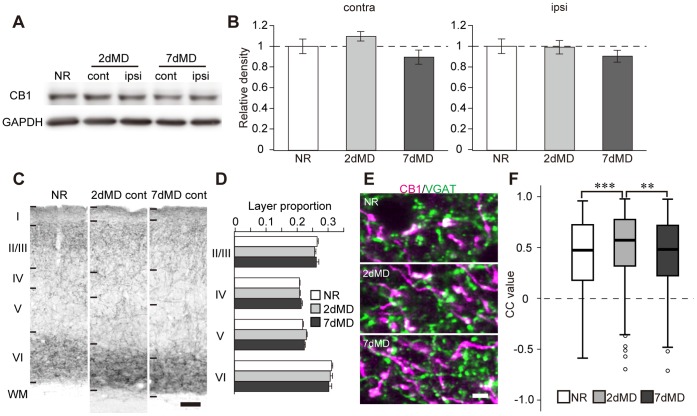
Effects of monocular deprivation on CB1 expression.(A) Representative western blots of CB1 and GAPDH in V1∶2 dMD and 7 dMD indicate monocular deprivation for two days and seven days, respectively. The blots of V1, which is contralateral (cont) or ipsilateral (ipsi) to the deprived eye, are represented with that of the normal animal (NR). (B) Mean and SEM of the blot density of CB1 in MD animals normalized to the mean of normal animals (n = 10 animals each, one-way factorial ANOVA, p>0.05). (C) Representative photographs of CB1 immunoreactivity in V1 of normal and MD animals. Scale, 100 µm. (D) Layer proportion of CB1 immunoreactivity was not significantly different among animal groups (two-way ANOVA, p>0.05). (E) Double immunofluorescent staining of CB1 (magenta) and VGAT (green) in the deep layer of V1 of normal and MD animals. The images of MD animals were obtained in the hemisphere contralateral to the deprived eye. Scale, 3 µm. (F) The CC values of CB1/VGAT in the deep layer of V1, which is contralateral to the deprived eye (n = 3 animals each; n = 386 ROIs (NR), 380 ROIs (2 dMD), 389 ROIs (7 dMD), Bonferroni-corrected Mann-Whitney U-test, **: p<0.0033, ***: p<0.00033).